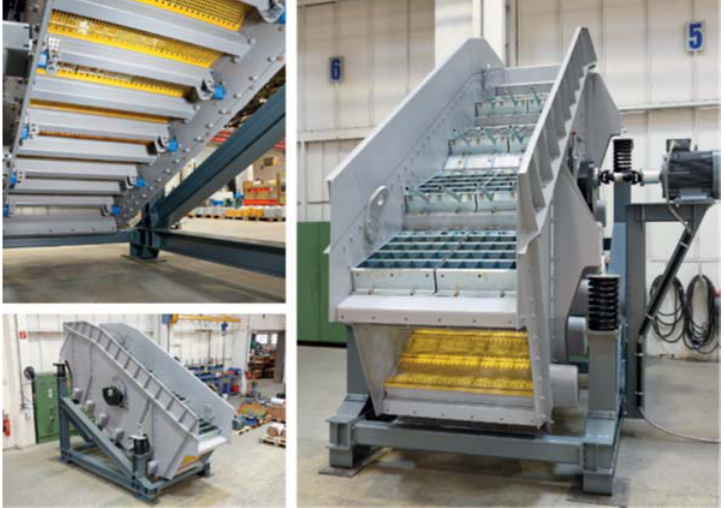
Figure 3. VARIOMAT double ‐ deck screen (manufactured by IFE).